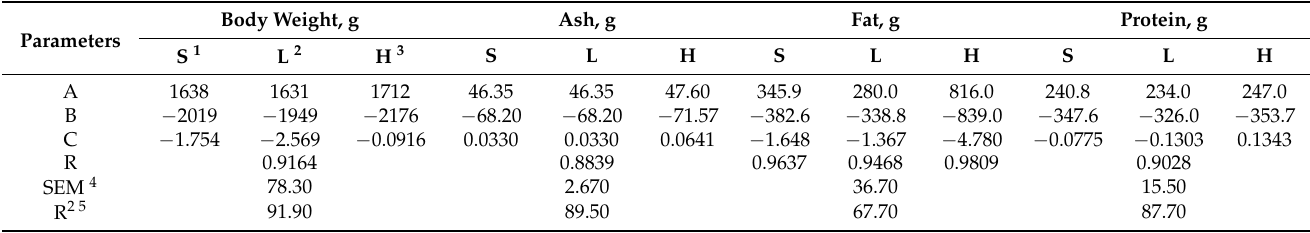
Table 8. Coefficients from linear plus exponential equation for body weight and body composition of laying hens from 8 to 102 weeks old in response to age in three dietary balanced protein levels.